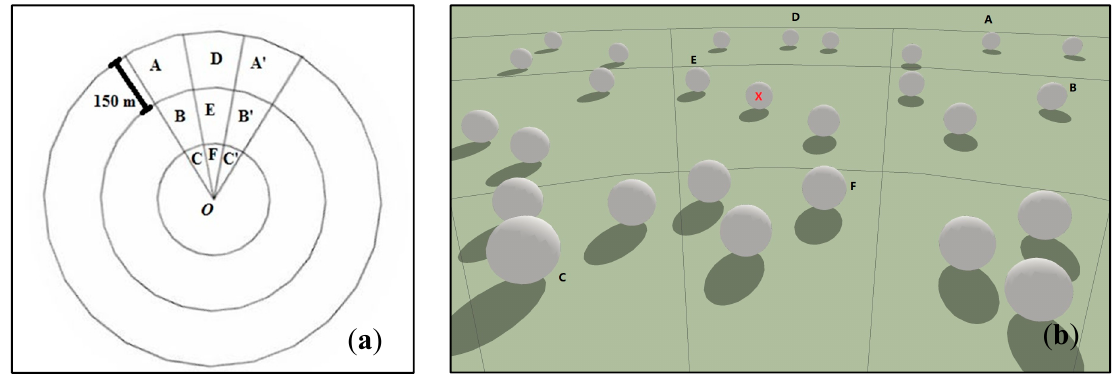
Figure 3. ( a ) Six position regions for Exp. 2; ( b ) An example of how the objects were located within the six regions.